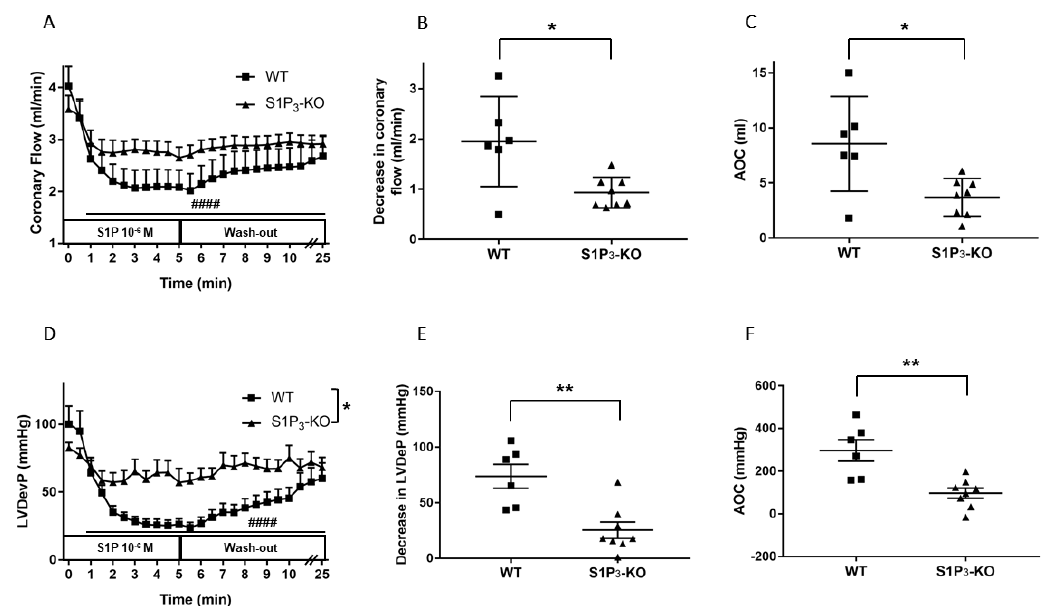
Figure 4. E ff ects of S1P on coronary flow (CF) ( A – C ) and left ventricular developed pressure (LVDevP) ( D – F ) of hearts isolated from wild-type (WT) and S1P 3 knock-out (KO) mice. S1P (10 − 6 M) was administered to the perfusate of isolated WT and S1P 3 -KO murine hearts for 5 min. The infusion was followed by a 20-min wash-out period. CF and LVDevP are shown in panels A and D. Maximal decrease in CF and LVDevP compared to preinfusion baseline are shown in panels B and E. Values of area over the curve (AOC) during S1P infusion are shown in panels C and F. In S1P 3 -KO hearts, the S1P-induced CF and LVDevP reduction was significantly reduced. Mean ± SEM; n = 6, 8; #### p < 0.0001 vs. baseline (preinfusion value); * p < 0.05, ** p < 0.01 vs. WT; two-way repeated measurement ANOVA and Dunnett’s post hoc test ( A , D ) and unpaired t -test ( B – F